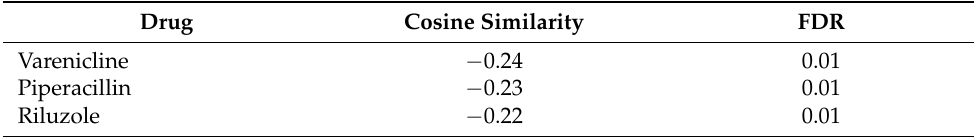
Table 4. Predicted drugs known to pass the blood-brain